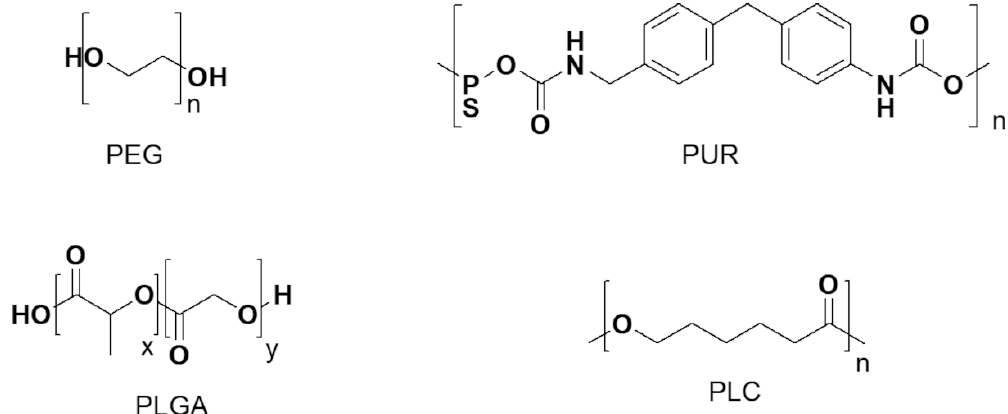
Figure 10. Some of the most used organic polymers adopted to produce nanosized GRAS delivery systems.